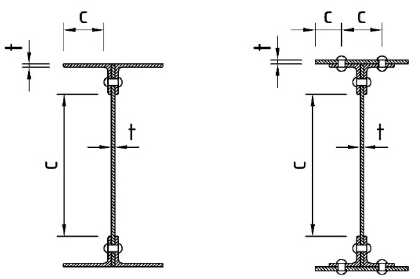
Figure 8. Definition of widths for the classification of riveted I-sections.